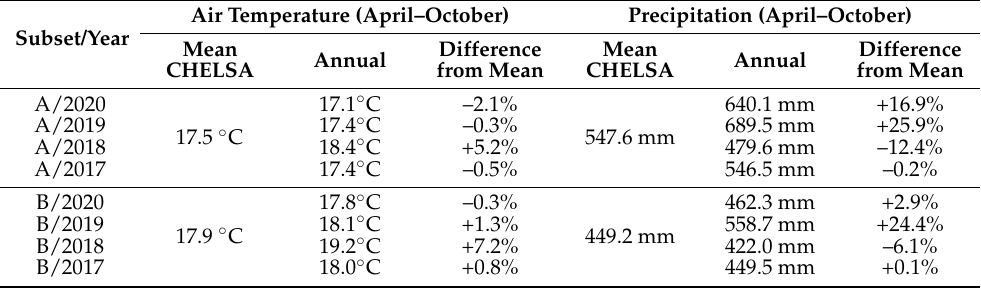
Table A1. Climate properties of subset areas per year in the 2017–2020 period between April and October.